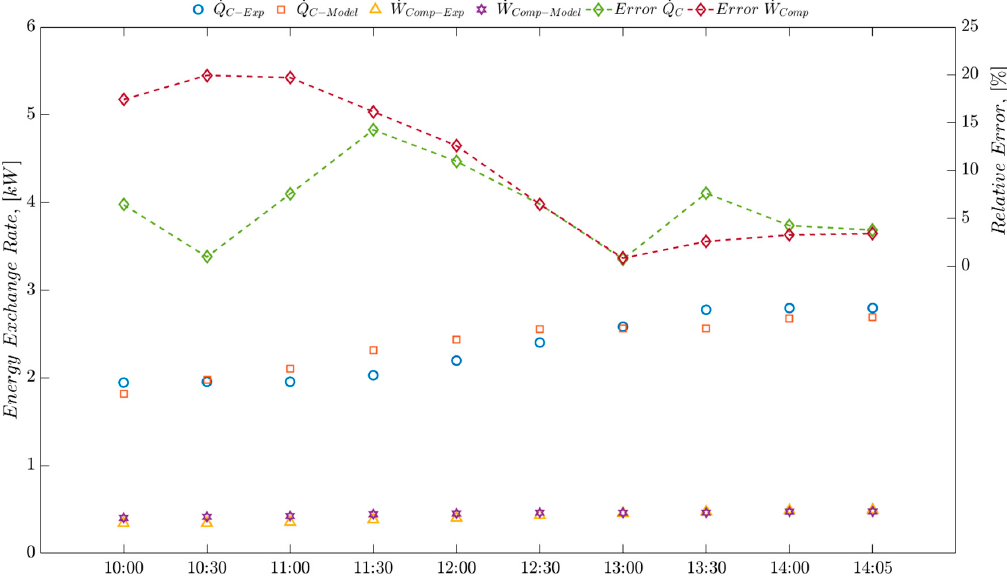
Figure 7. Comparison with experimental data published by Cutic et al. [19].